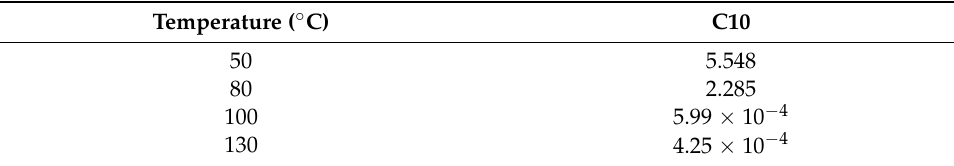
Figure 7. Elastic modulus versus time at different temperatures.